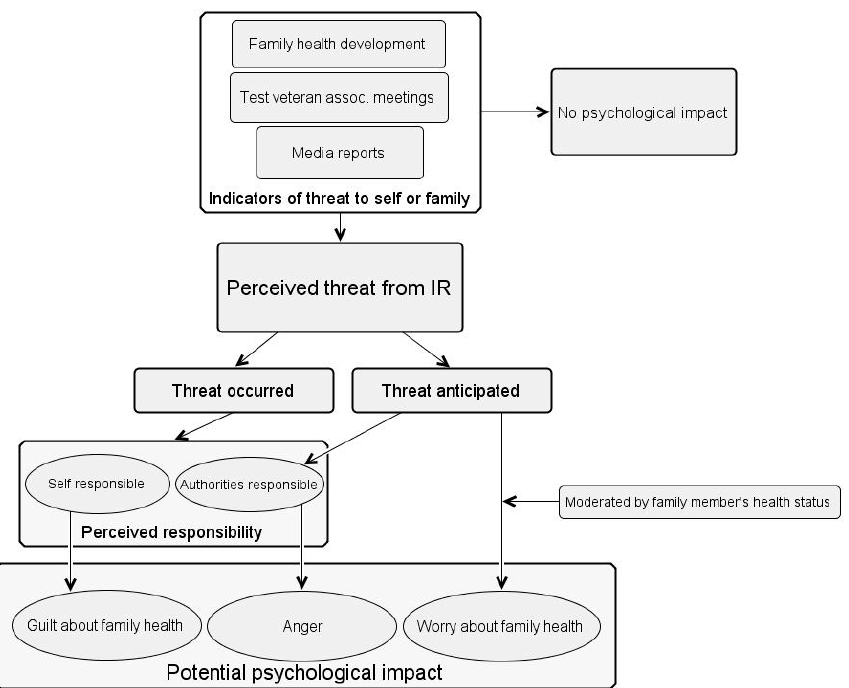
Figure 3. Conceptual model illustrating the potential psychological impact in British nuclear test veterans. The potential psychological impact relevant to the interview participants, namely guilt about family health, anger, and worry about family health. Family health development and health risk information shared through veteran association meetings and media reports serve as indicators of health threats to self or family. Guilt appears to arise out of perceived self-responsibility for threats to family member’s health which have already occurred. Anger may arise out of perceiving authorities as responsible (due to perceived negligence and deception) for past threats and anticipated threats to health. Lastly, worry may arise out of anticipated threats to health, but it is strongly related to family member’s health